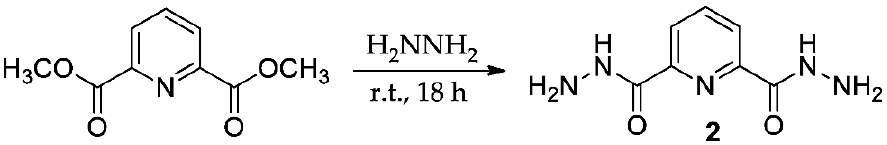
Figure 1. Microwave-assisted synthesis of 6-iodo-2-methyl-4 H -benzo[ d ][1,3]oxazin-4-one. Then, pyridine-2,6-dicarbohydrazide ( 2 ) was synthesized (Figure 2) according to Molnar et al. [22].